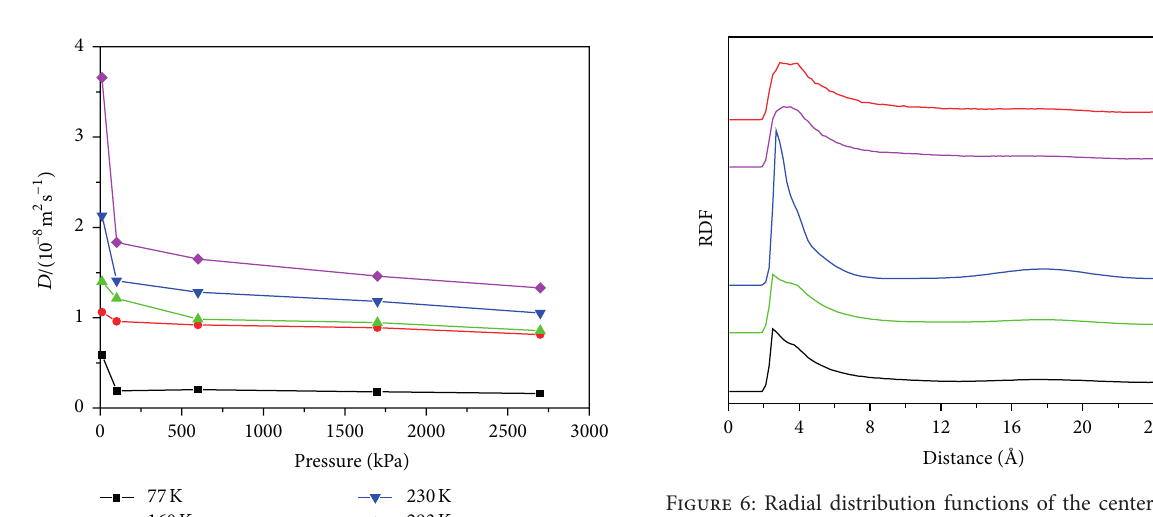
Figure 6: Radial distribution functions of the center of mass for hydrogen molecules at different pressures: (a) 10kPa, (b) 100kPa, (c) 600 kPa, (d) 1700 kPa, and (e) 2700 kPa at